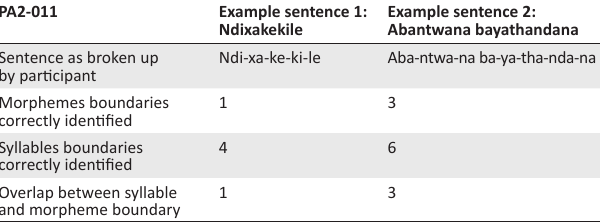
TABLE 3: Example of decomposition coding: Real answer given by a participant.